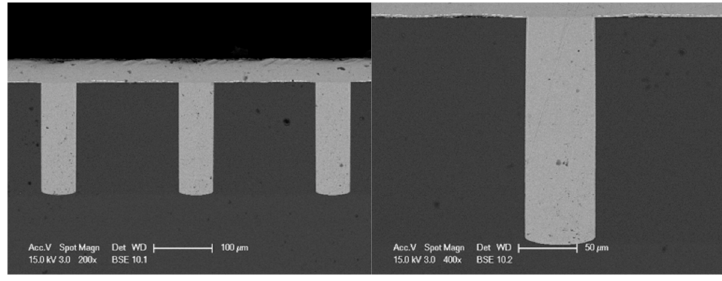
Figure 11. SEM image of void-free filled TSV.